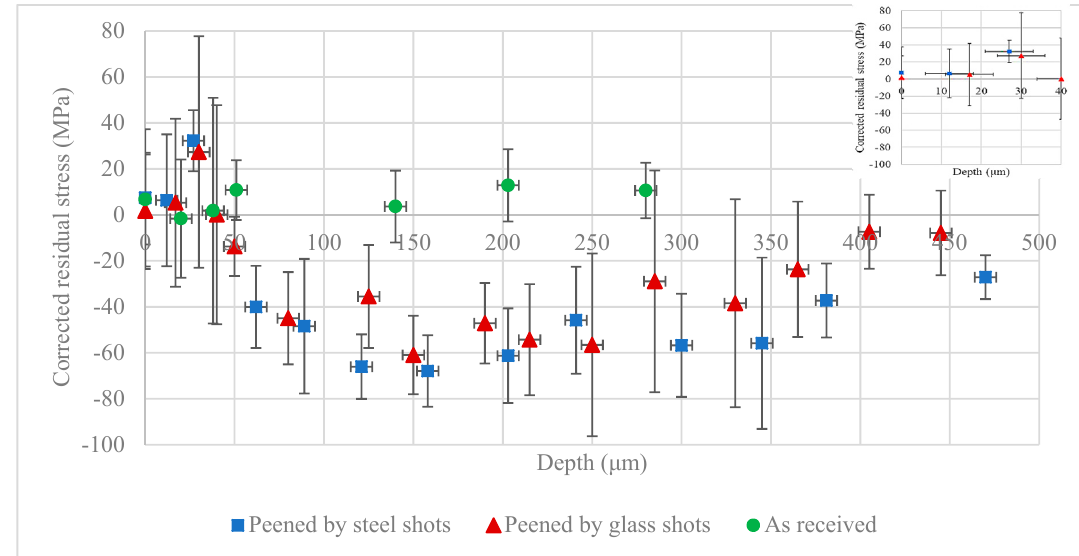
Figure 7. Corrected residual stress on the as-received AZ31B-H24 plate and after shot peening with steel and glass shots.